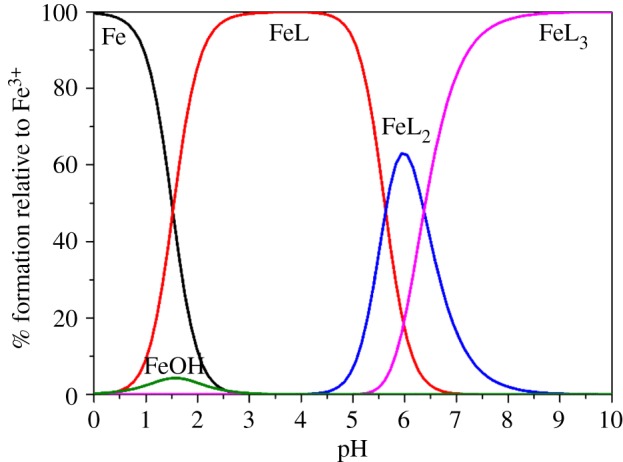
Species distribution curves of FeIII–L1H2 complex, calculative condition: [L1H2] = 3 × [FeIII] = 2.0 × 10−4 M, the charge numbers are omitted for clarity.